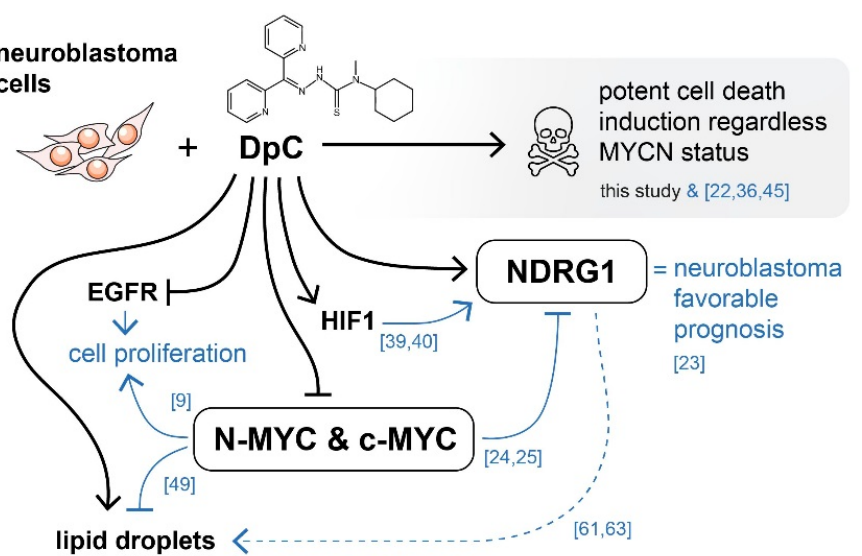
Figure 9. Graphical overview of the major molecular targets affected by DpC treatment in neuroblas- toma. Black arrows indicate findings of this study. Blue arrows represent existing knowledge (see references), providing a mechanistic insight into the effects of thiosemicarbazones in the context of neuroblastoma cells. DpC suppressed the expression of EGFR and MYC proteins in all studied neuroblastoma cell lines. Additionally, the treatment induced a massive increase in NDRG1 levels, as well as lipid droplet accumulation. Although the involvement of NDRG1 in lipid accumulation